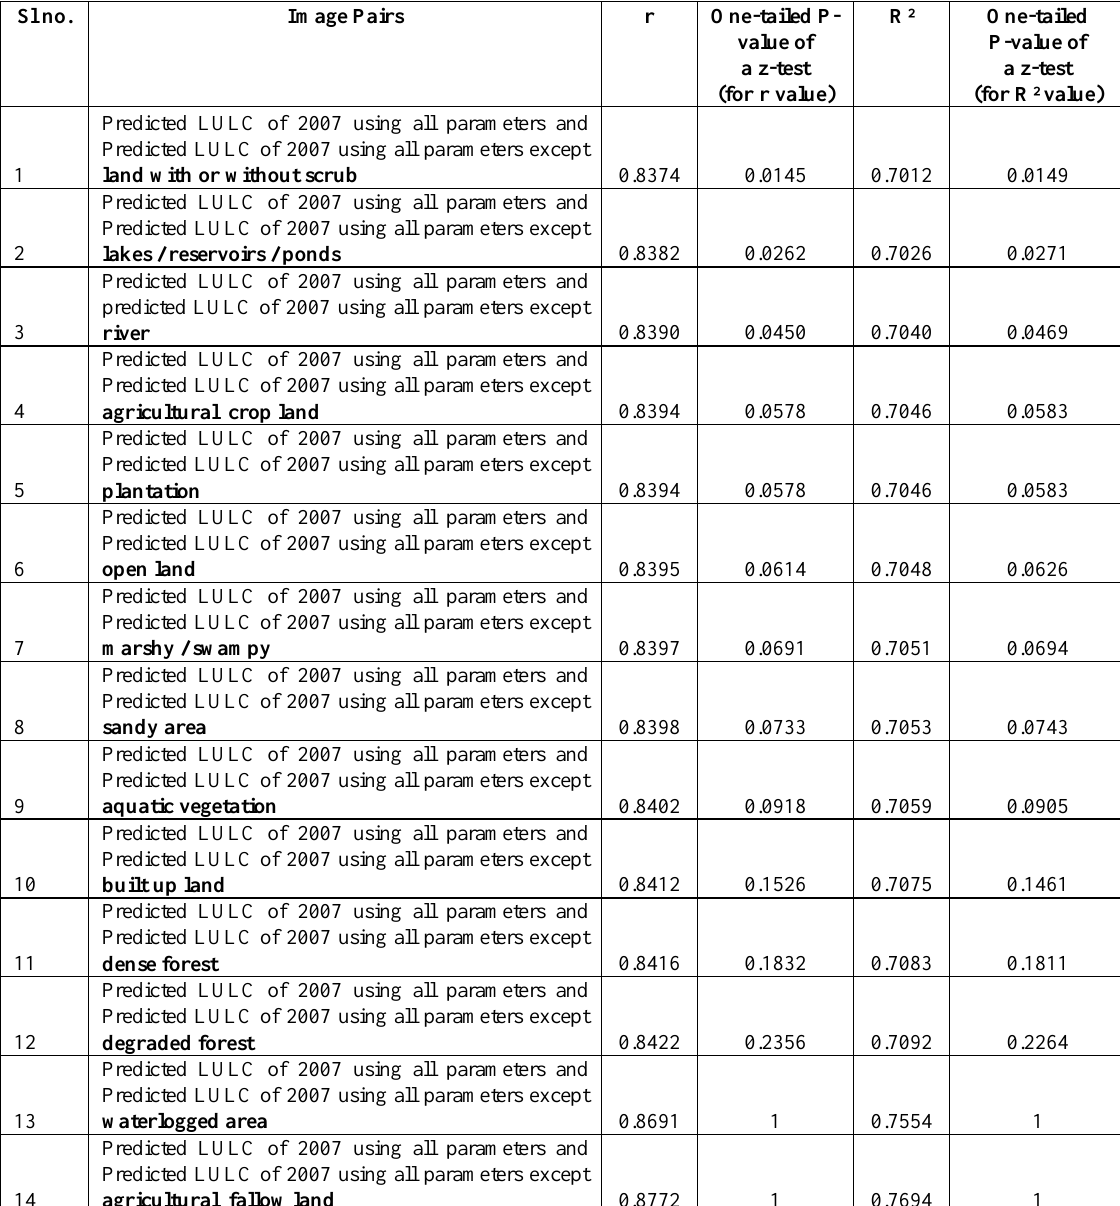
Appendix 2: Ranking (descending order) of relationship between predicted LULC of 2007 using all parameters and predicted LULC of 2007 using all parameters except any one parameter Sl